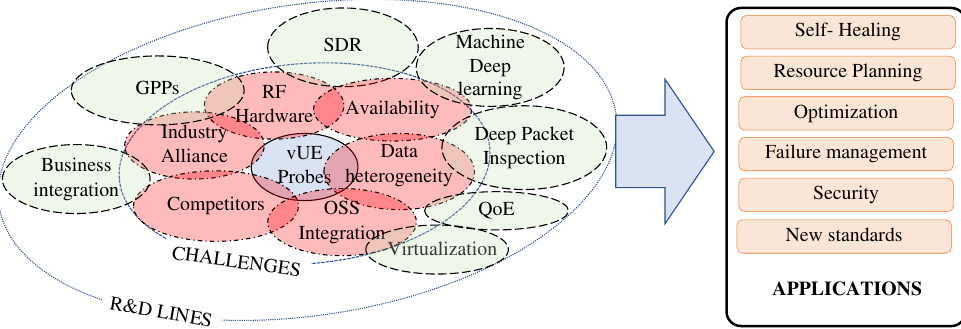
Figure 14. Applications, challenges and identified R&D